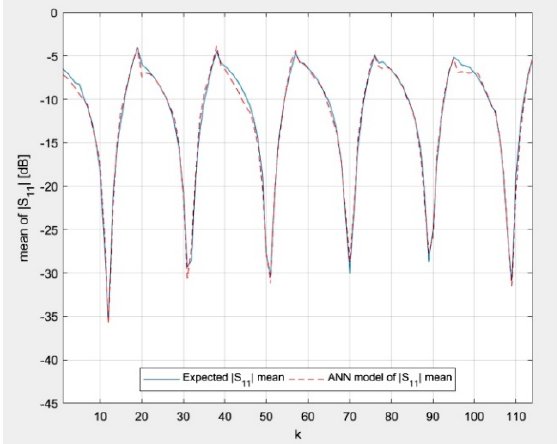
Figure 16. The expected and modeled mean of | S 11 | of an ordinary patch antenna for the range of the first set of testing data.